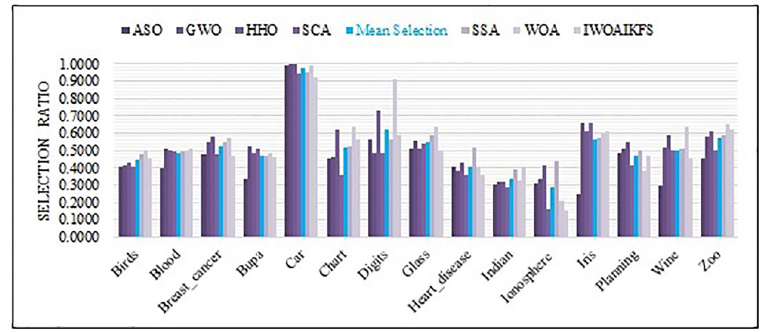
Fig 10. The selection ratio of IWOAIKFS compared to other